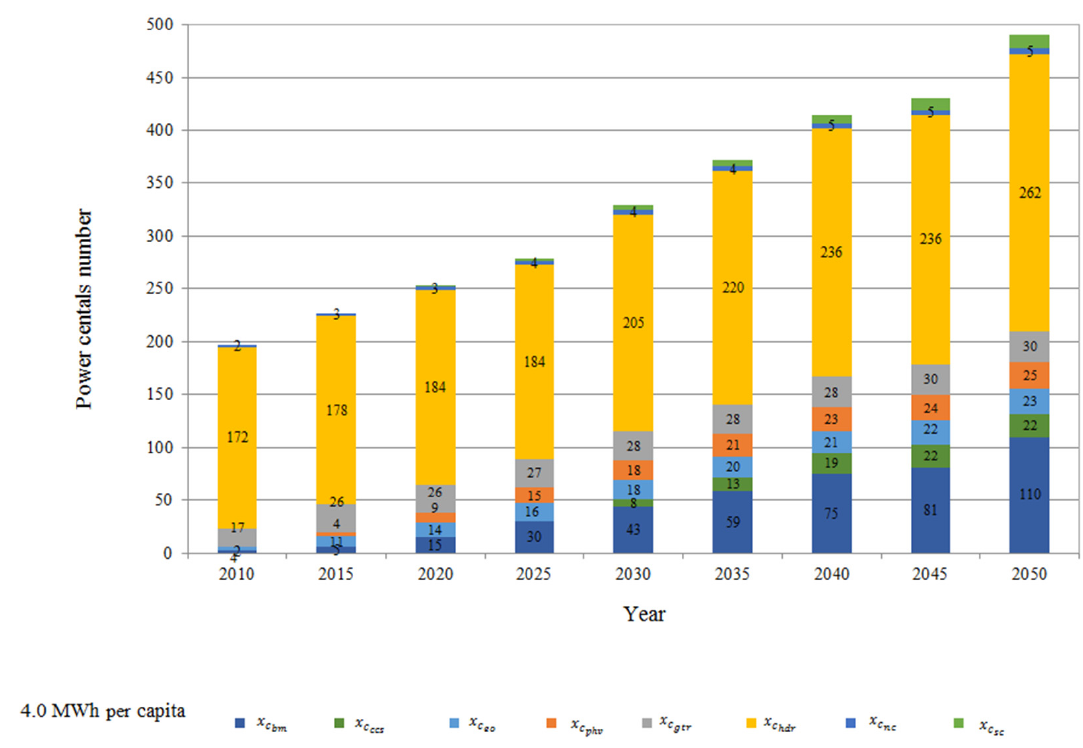
Figure 20. Optimized power plants number from clean energy resource for 4.0 MWh per capita demand with the CVF model.